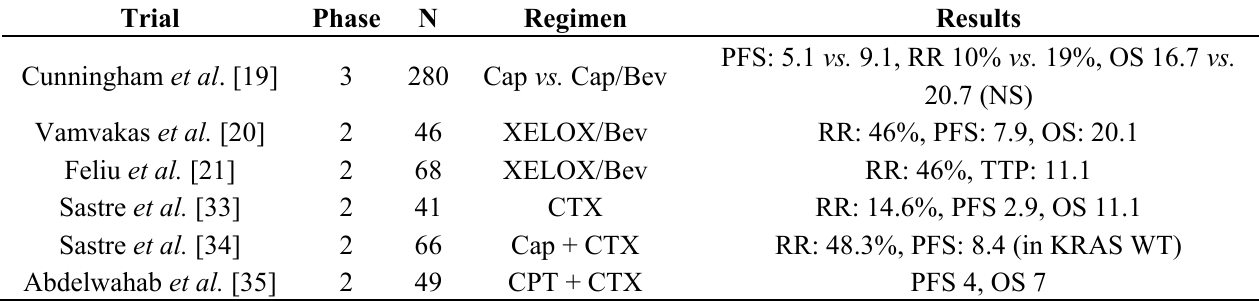
Table 1. Summary of prospective trials evaluating biologic agents specifically in older patients with